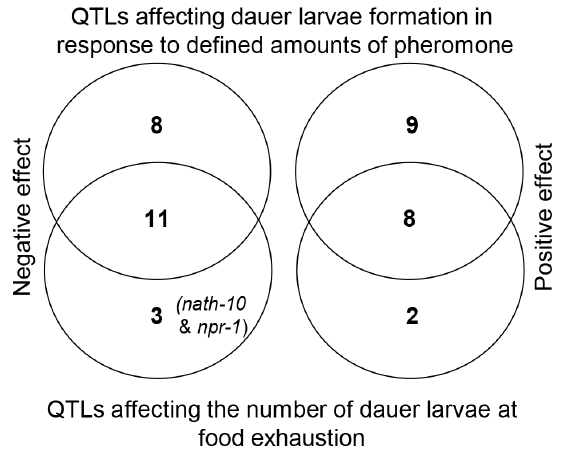
Figure 6. Most QTLs affecting the number of dauer larvae at food exhaustion in growing populations overlap with QTLs affecting dauer larvae formation in response to defined amounts of pheromone. Venn diagrams showing the overlap between QTLs that affect dauer larvae development in response to defined amounts of pheromone (upper circles) and QTLs that affect the number of dauer larvae at food exhaustion in growing populations (lower circles). Negative effect QTLs, where the CB4856 allele decreases the number of dauer larvae, are shown in the left hand diagram and positive effect QTLs, where the CB4856 allele increases the number of dauer larvae, are shown in the right hand diagram.